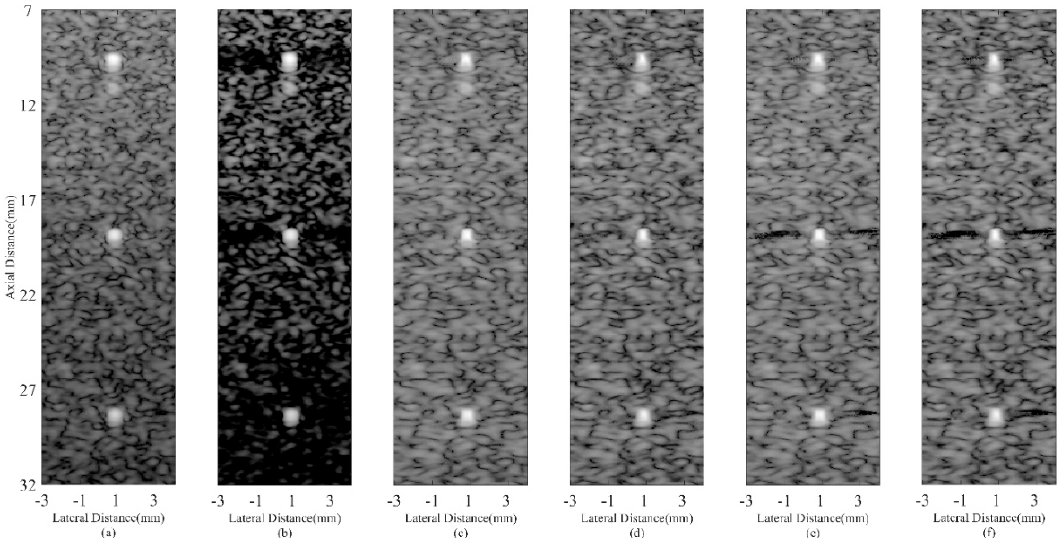
Figure 5. Experimental point targets phantom using different beamformers: ( a ) DAS, ( b ) CF, ( c ) JTR-MV, ( d ) JTR-MV GCF, ( e ) JTR-ESBMV, ( f ) JTR-ESBMV GCF. All images are shown with a dynamic range of